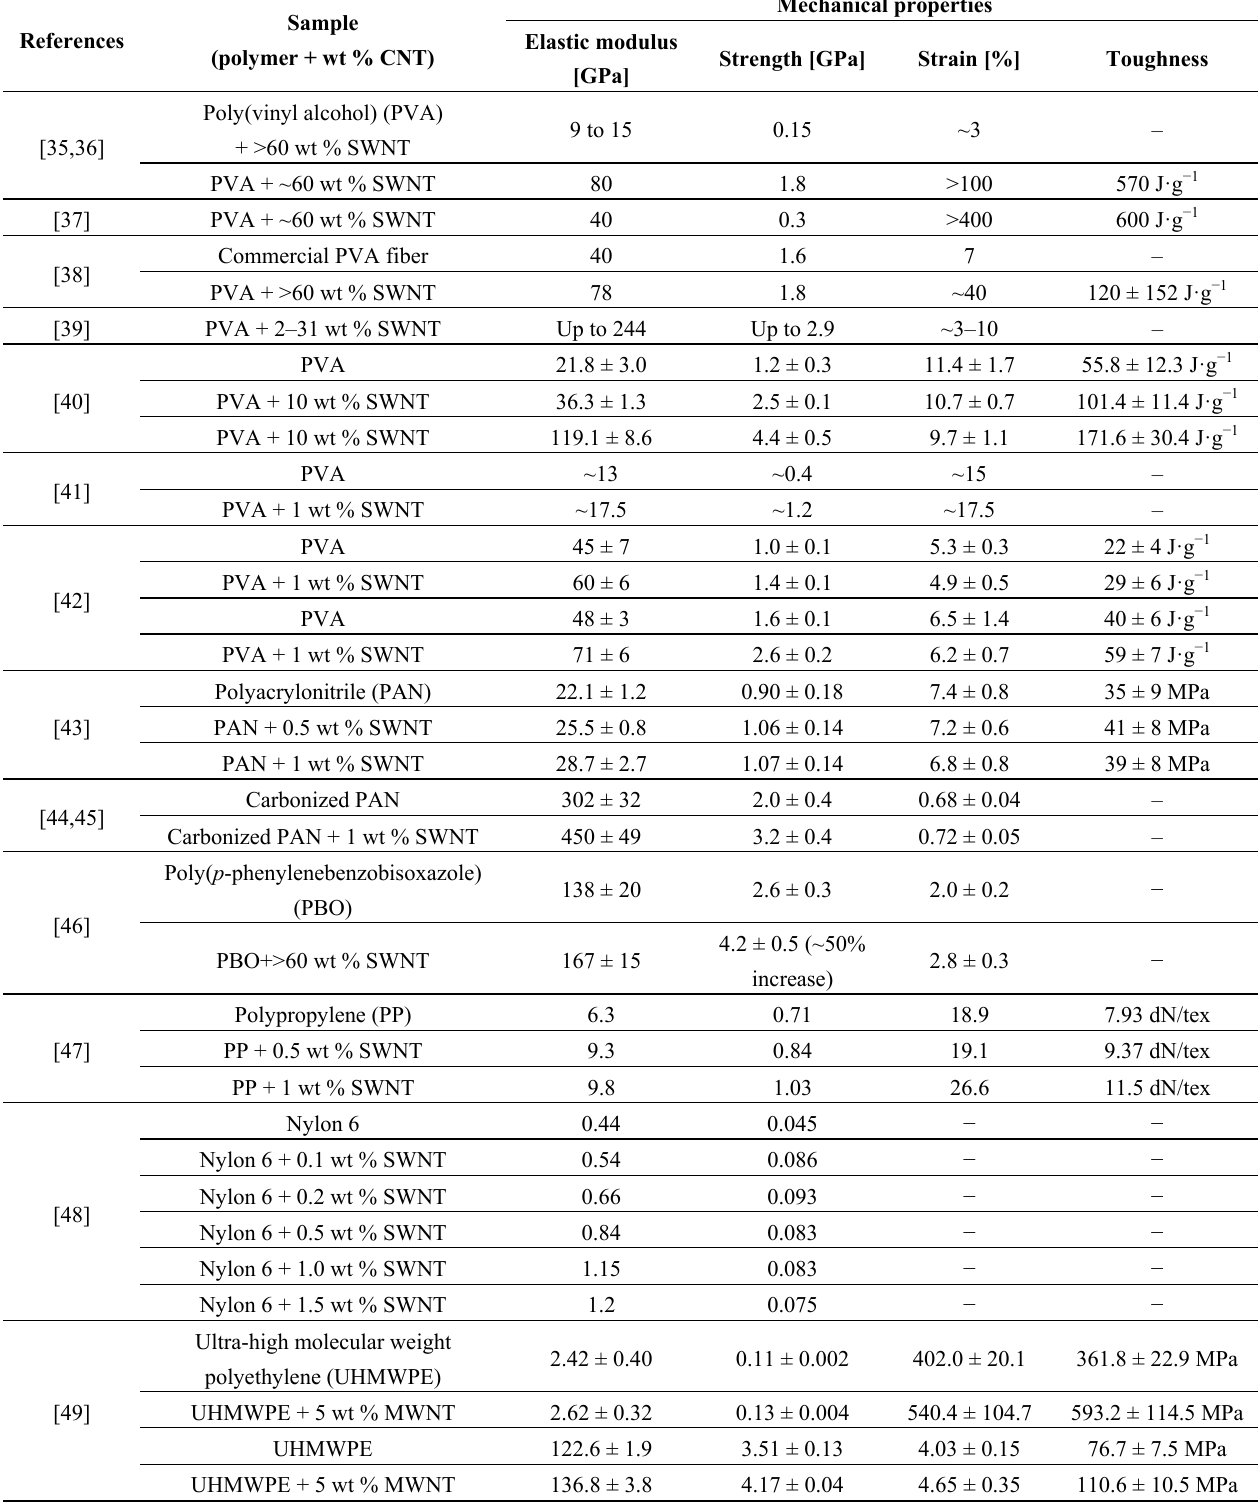
Table 2. Summary of the typically reported mechanical properties for polymer-based carbon nanotube composite